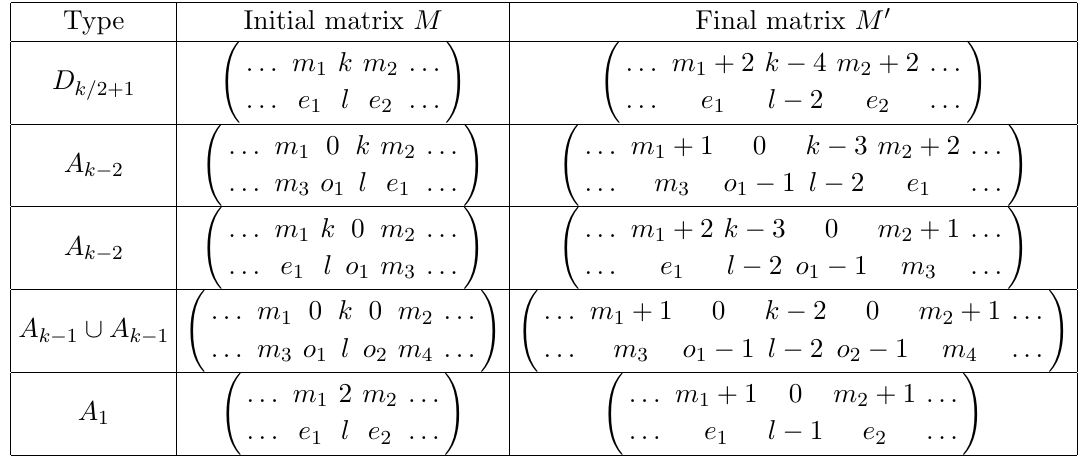
Table 8. Classi(cid:12)cation of surface singularities type Kraft-Procesi transitions for orthosymplectic brane con(cid:12)gurations in the matrix formalism . The number k follows the restrictions of the (cid:12)ve di(cid:11)erent cases labelled from (a) to (e) in section 9.3.1. The number l is any integer greater than number. M is a matrix before the KP transition is performed. M 0 depicts the matrix after the KP transition is performed. The KP transition is a local process: the dots represent the parts of the matrices that are not a(cid:11)ected by the KP